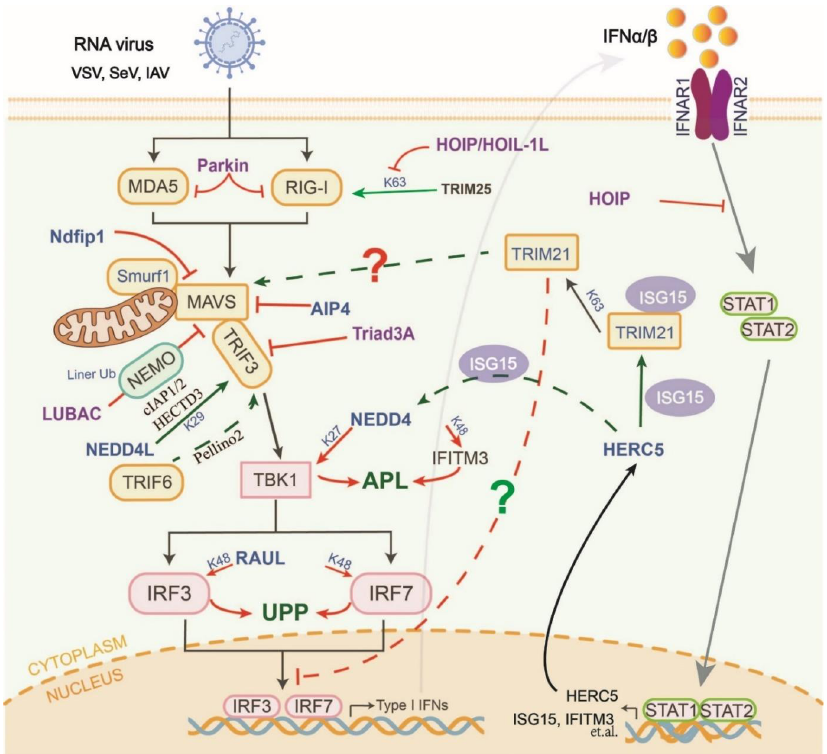
Figure 3. The members and mechanisms of HECT- and RBR-type E3s that regulate RLR and cGAS- STING signaling pathways. HECT-type E3s mainly mediate protein degradation via the UPP or ALP to inhibit the activation of RLR (e.g., RAUL, NEDD4, Parkin, etc.). On the other hand, HECT- and RBR-type E3s indirectly regulate the activation of the pathways by targeting other E3 enzymes (e.g., HOIP/HOIL-1L and HERC5). In particular, the relationship between HERC5-mediated ISGyla- tion and RLR signaling axis needs further study. RBR-type E3s are also involved in regulating downstream IFN signaling pathways (e.g., HOIP). The solid line represents the direct regulation effect (arrow: positive regulation; short line: negative regulation), the dotted line represents the in- direct regulation effect; the question mark represents no experimental verification.